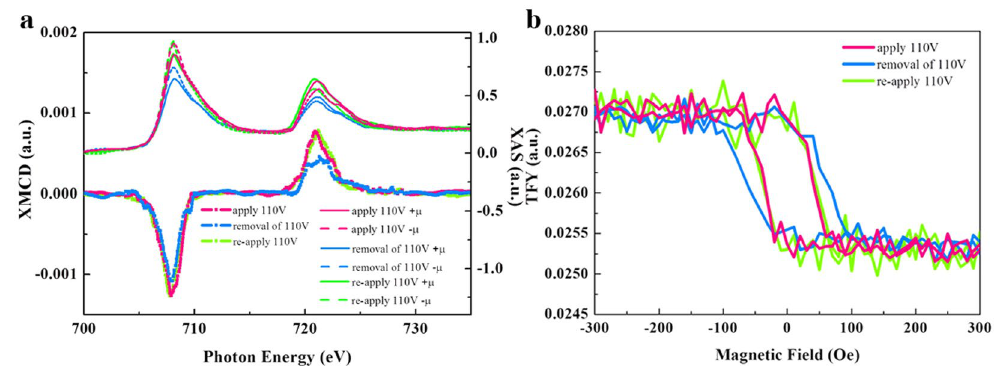
Figure 6. Reversibility test of in-situ treatment by x-ray. ( a ) Lower figure: Fe L 2 / L 3 XMCD spectra with application (pink), removal (blue), and reapplication (green) of 110 V- in-situ treatment ; upper figure: helicity- dependent ( μ ( + ) and μ ( − )) Fe L 3 XAS spectra with and without 110 V- in-situ treatment . ( b ) Hysteresis curves of the Fe layer with application (pink), removal (blue), and reapplication (green) of 110 V- in-situ treatment